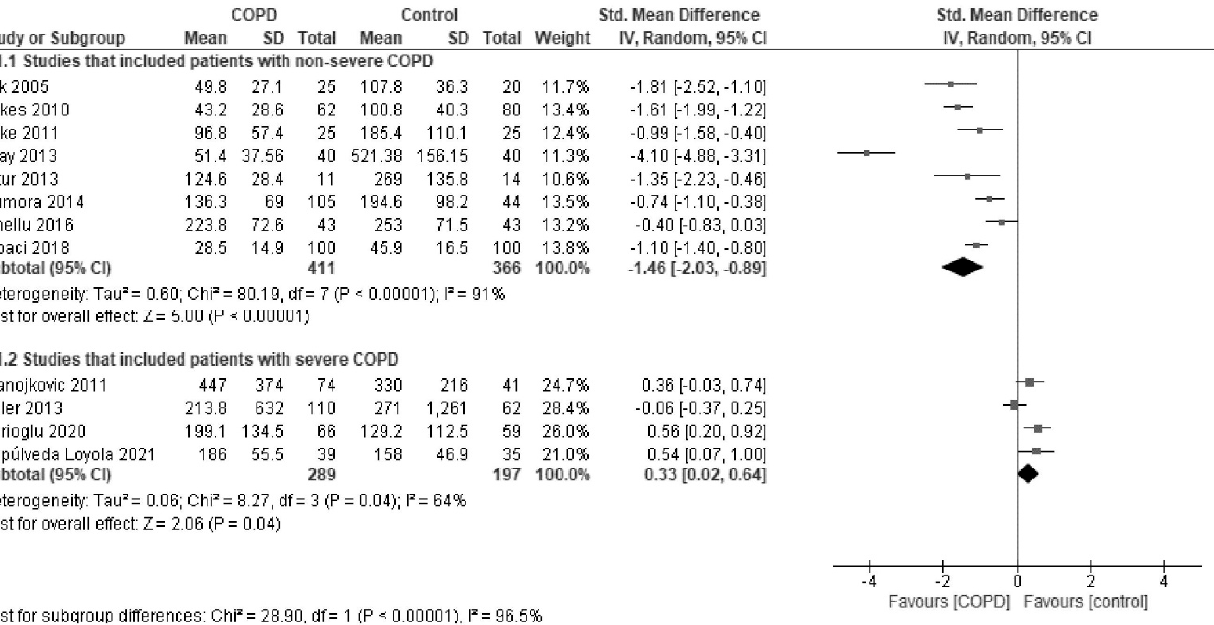
Figure 4. Forest plot of paraoxonase activity stratified by the severity of COPD.